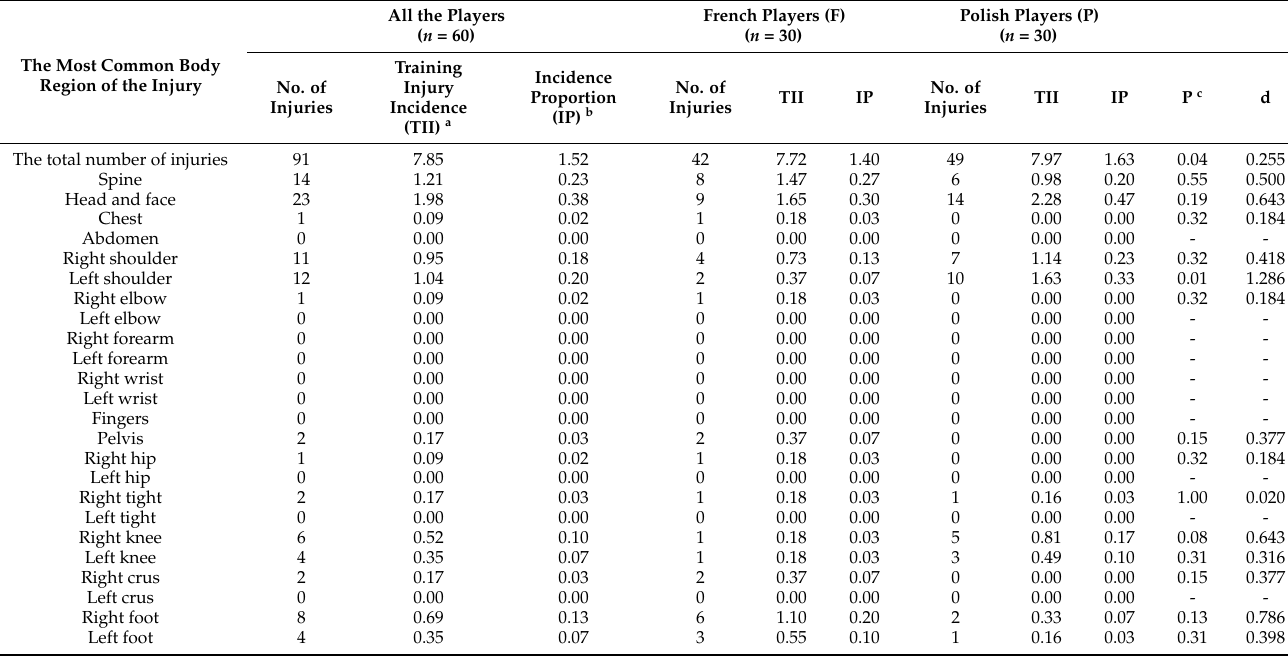
Table 4. Rugby injuries reported by rugby players ( n = 60) by body